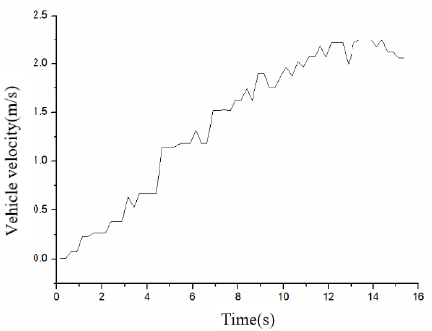
Figure 7. Vehicle velocity of non-controlled strategy.